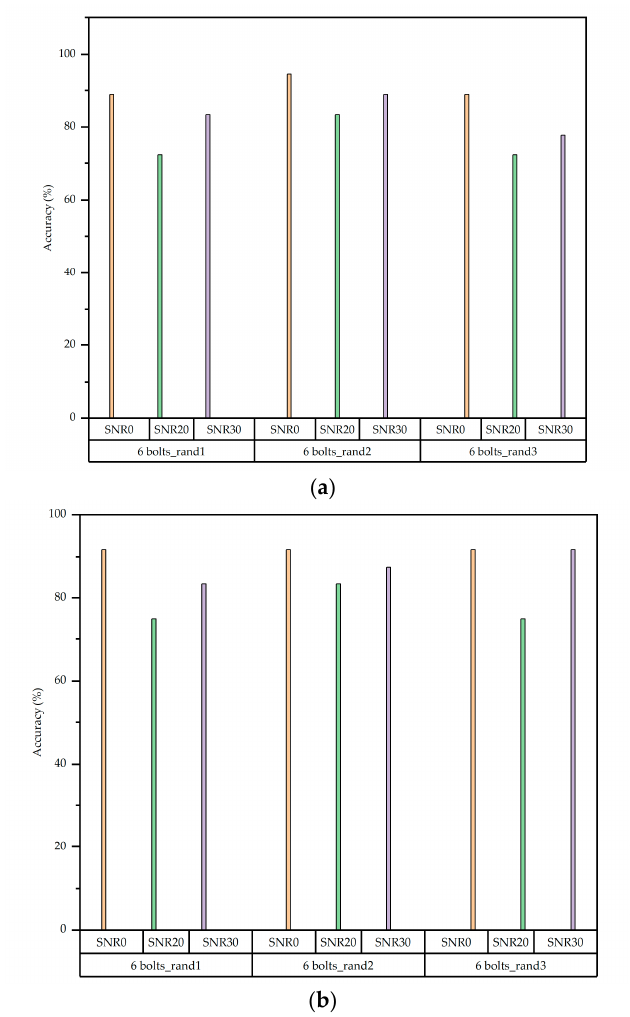
Figure 20. Multi-condition prediction accuracy comparison chart (10%-30% variable amplitude continuous impulse load): ( a ) 70% samples learning; ( b ) 60% samples learning.